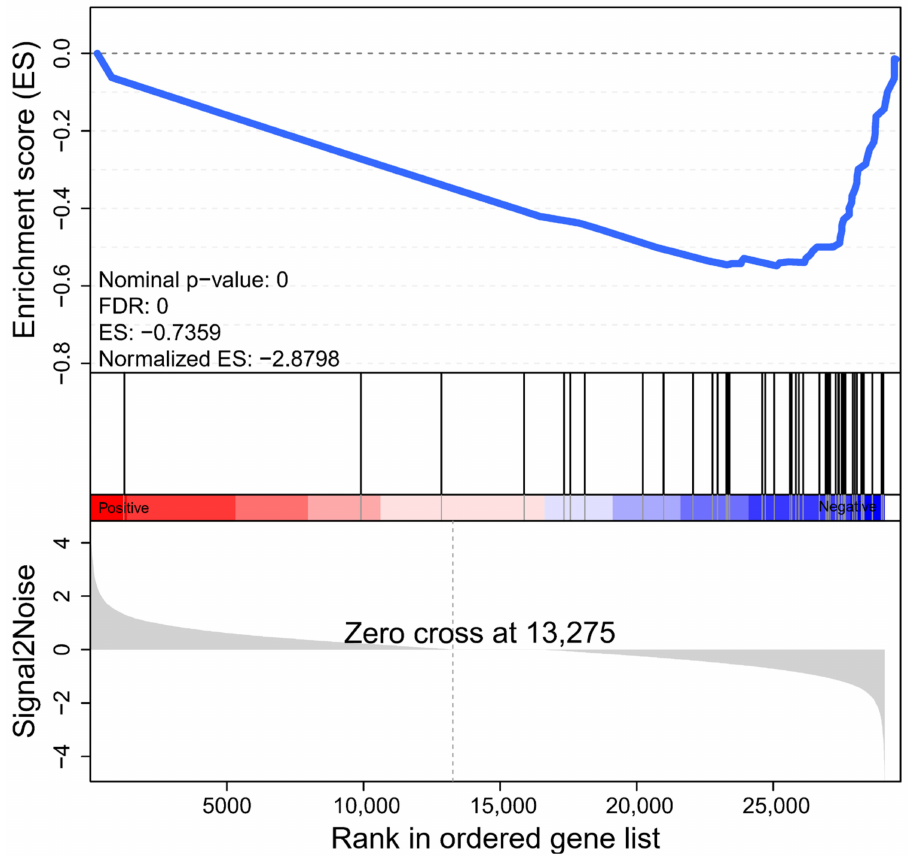
Figure 4. GSEA of all genes in the photosynthesis pathway. The folded line is the enrichment score (ES) of each gene, and the peak value is the ES of the gene set. The horizontal axis represents each gene in this gene set and corresponds to a vertical line similar to a barcode. ES: Enrichment Score. Normalized ES: Normalized ES value after correction. FDR: p -value after correction for multiple hypothesis testing. Probability estimates of possible false positive results for Normalized ES. The smaller the FDR, the more significant the enrichment is. Core genes are the genes before the peak for gene sets with positive ES. The core genes are the genes after the peak for the gene set with negative ES. Overall, if genes are enriched at the top of the curve, the gene set is up-regulated expression trend, and conversely, if they are enriched at the bottom, the expression trend is